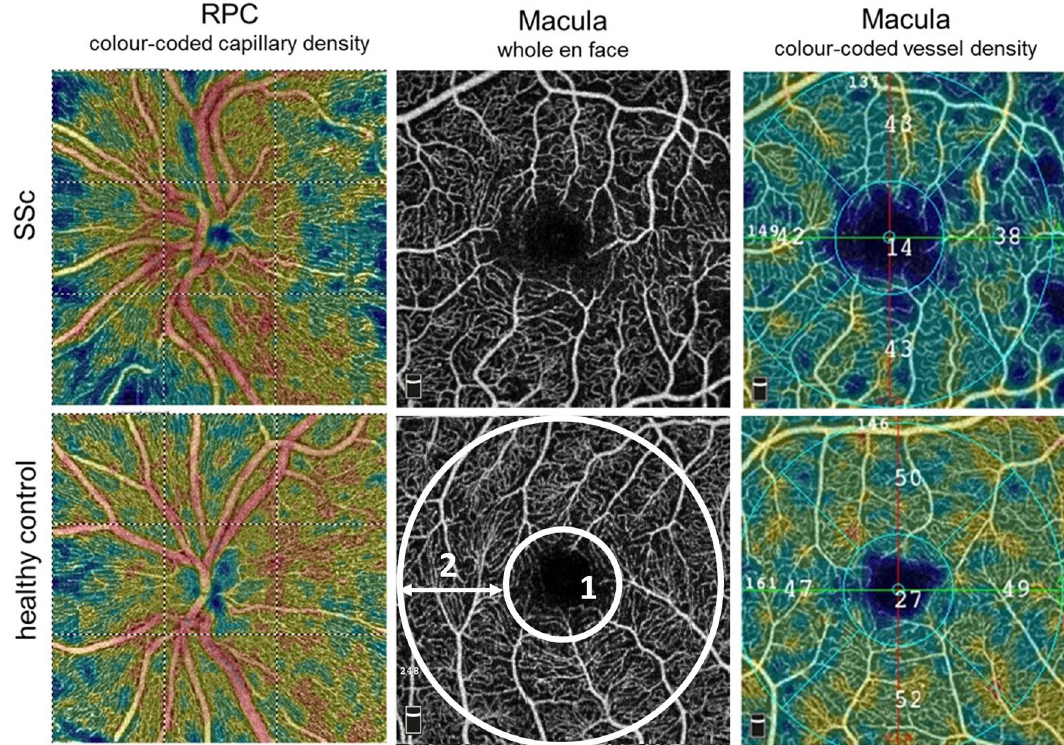
Figure 1. Optical coherence tomography angiography (OCTA). En face OCTA images of the macula (superficial 3 × 3 mm OCT angiogram) and optic nerve head (RPC = radial peripapillary capillary 4.5 × 4.5 mm) of a patient with definite systemic sclerosis (SSc, top row) and an age-matched healthy control (bottom row). The foveal vessel density (1) (diameter of 1 mm, small white circle), parafoveal vessel density (2) (diameter from 1 to 2.5 mm, big white circle) and whole en face vessel density [the average vessel density of the entire 2.5 mm circle (1 and 2)] were analyzed.